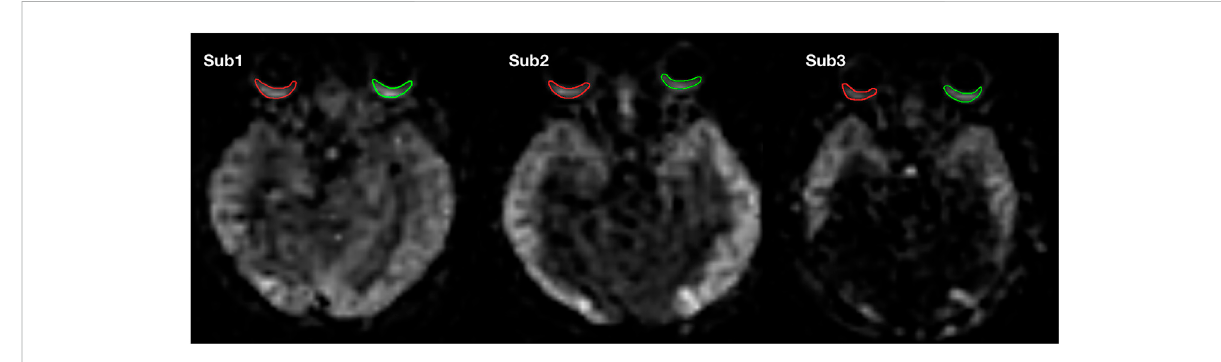
FIGURE 2 ROIs of one subject on the OBF map. Green represents the ROI of the left eye, and red represents the ROI of the right eye.